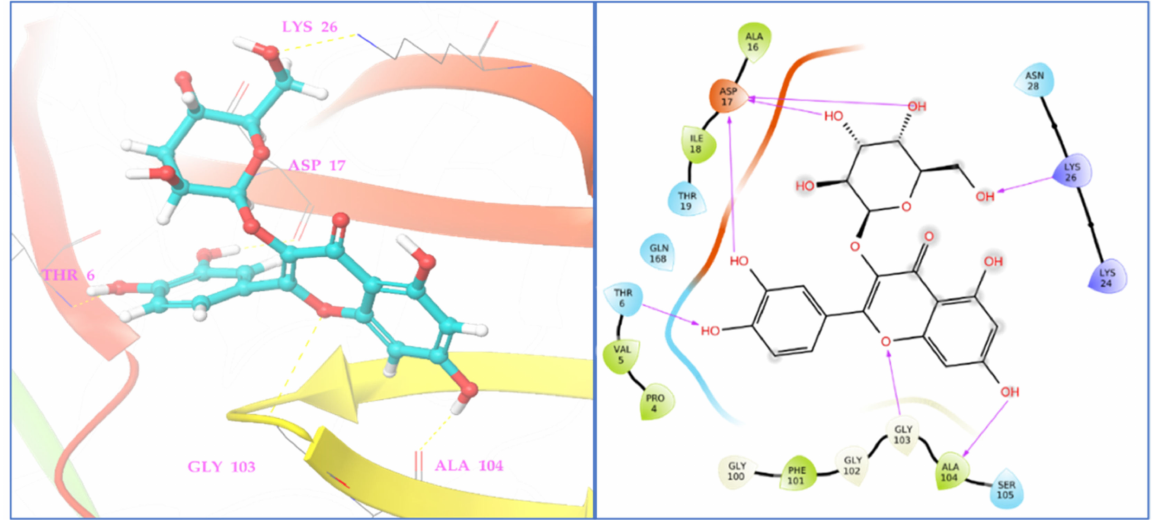
Figure 6. Two- and three-dimensional residual interactions network of hyperoside against the active site of C. albicans Sap1 (PDB ID: 2QZW).